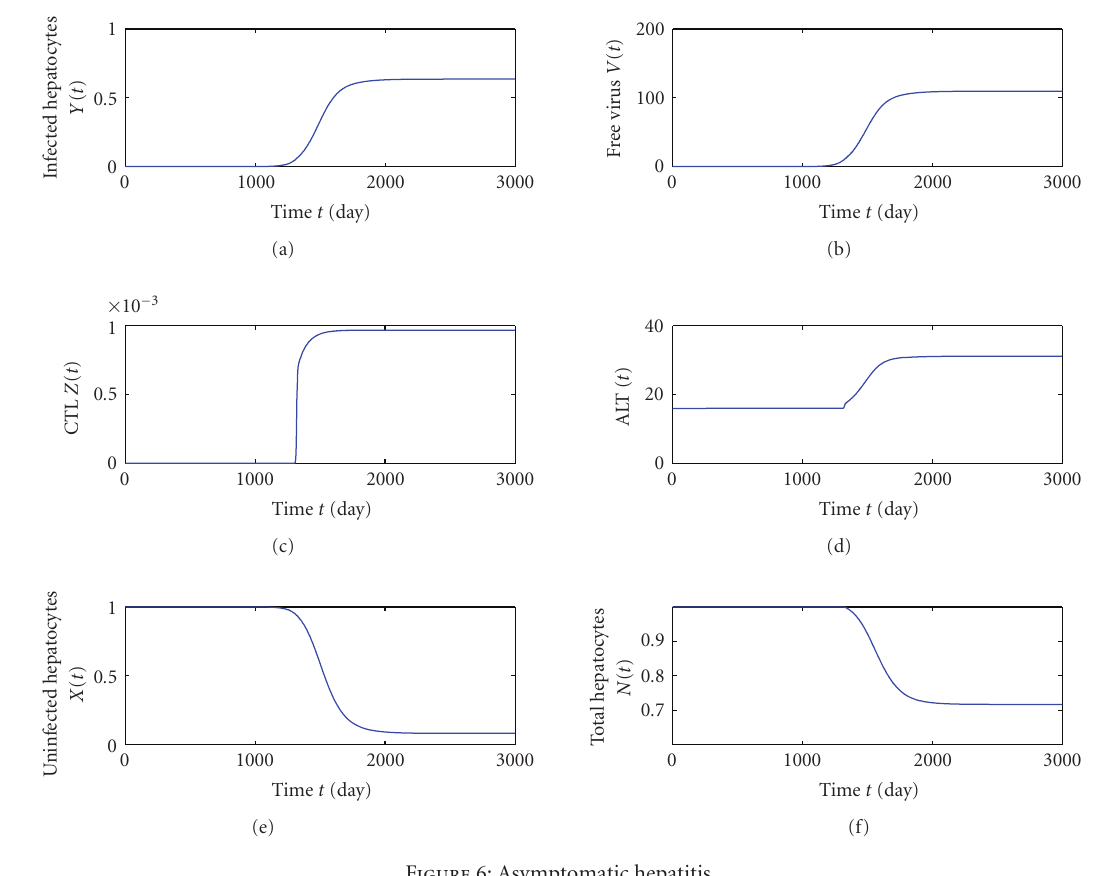
Figure 6: Asymptomatic